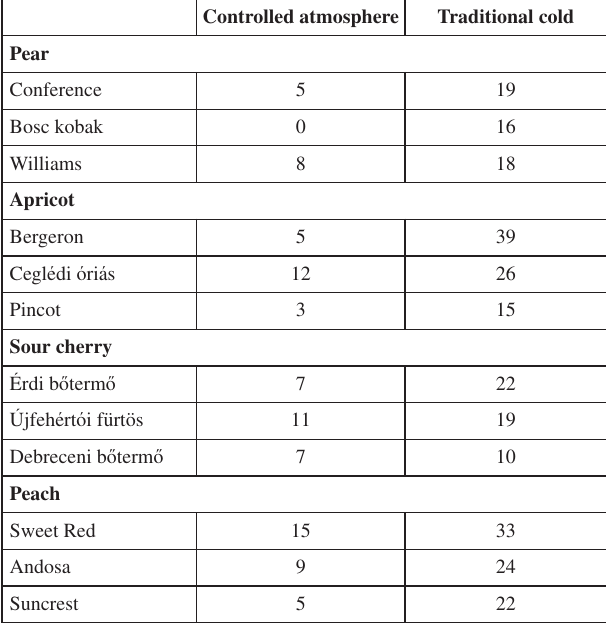
Table 2 Incidence of postharvest deacy of fruit of four fruit species under two storage conditions (Nagykanizsa, 2011) Controlled atmosphere